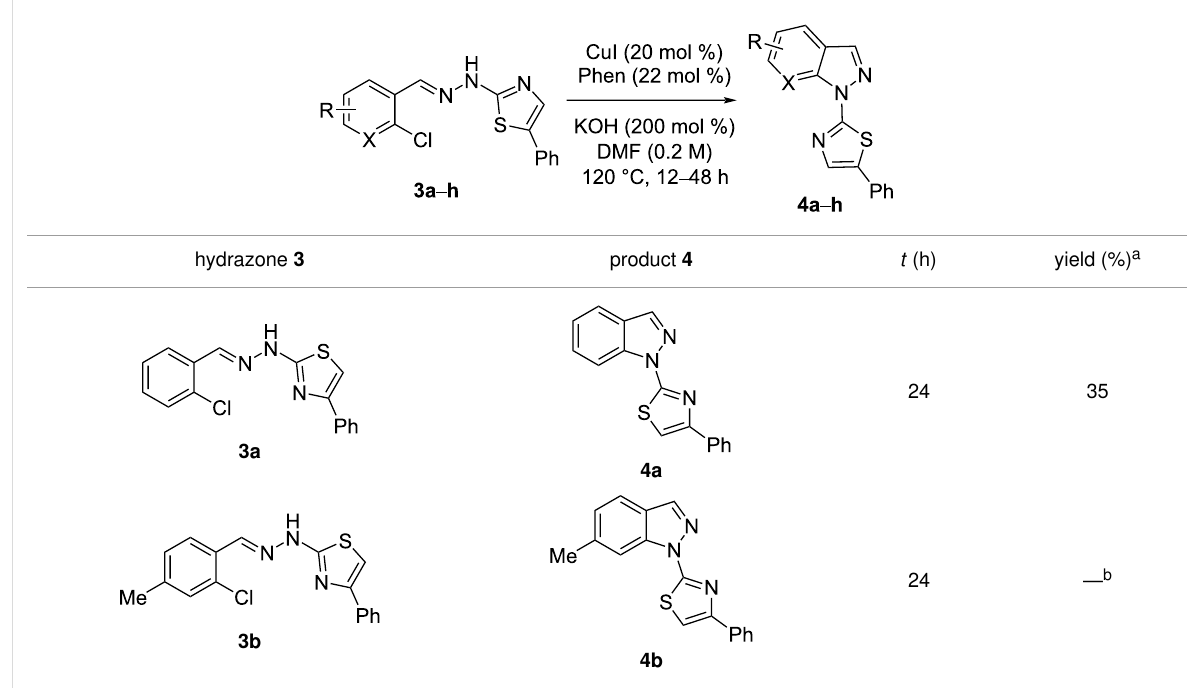
Table 3: Selected experimental data for the synthesis of N -thiazolyl-1 H -indazoles 4a , d – h